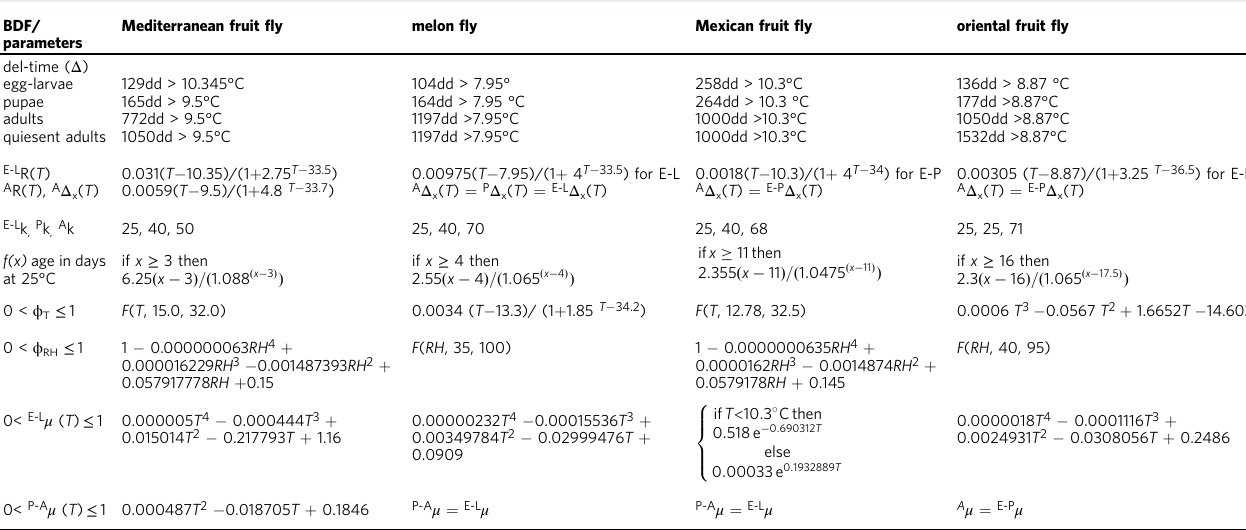
Table 2 Summary of biodemographic functions (BDFs) and parameters of four invasive tropical tephritid fruit fl ies from Figures